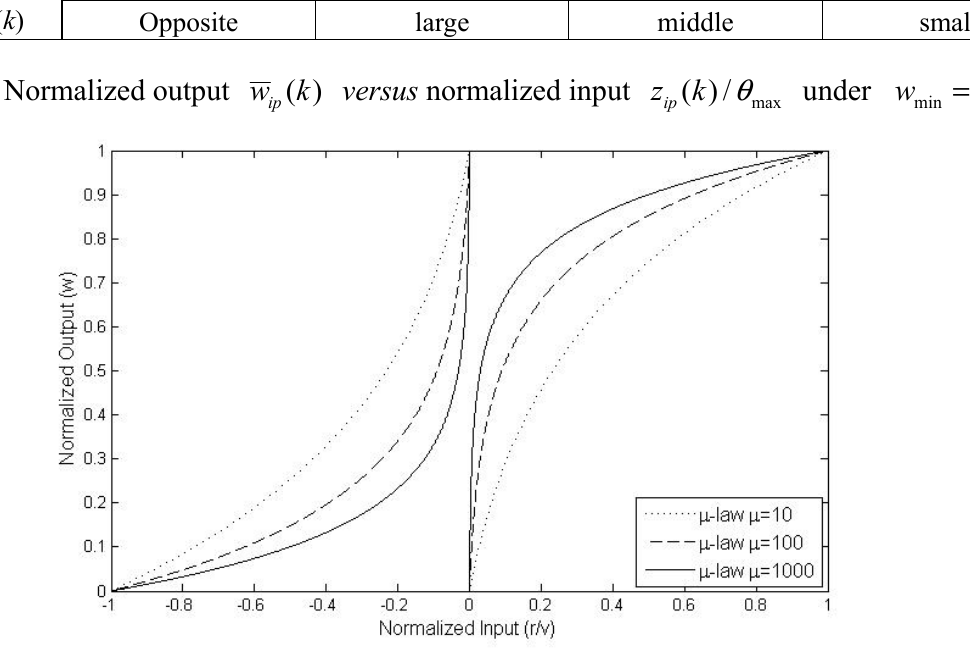
Figure 2. Flowchart illustrating the main steps of the